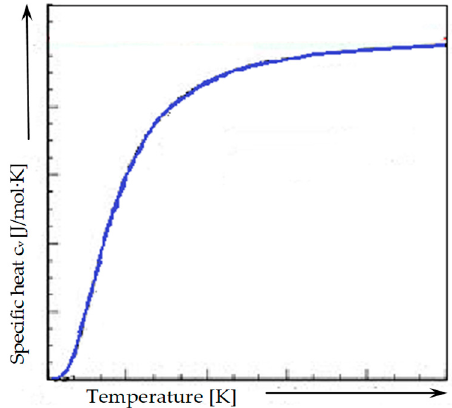
Figure 1. Thermal capacity dependence in function of temperature.